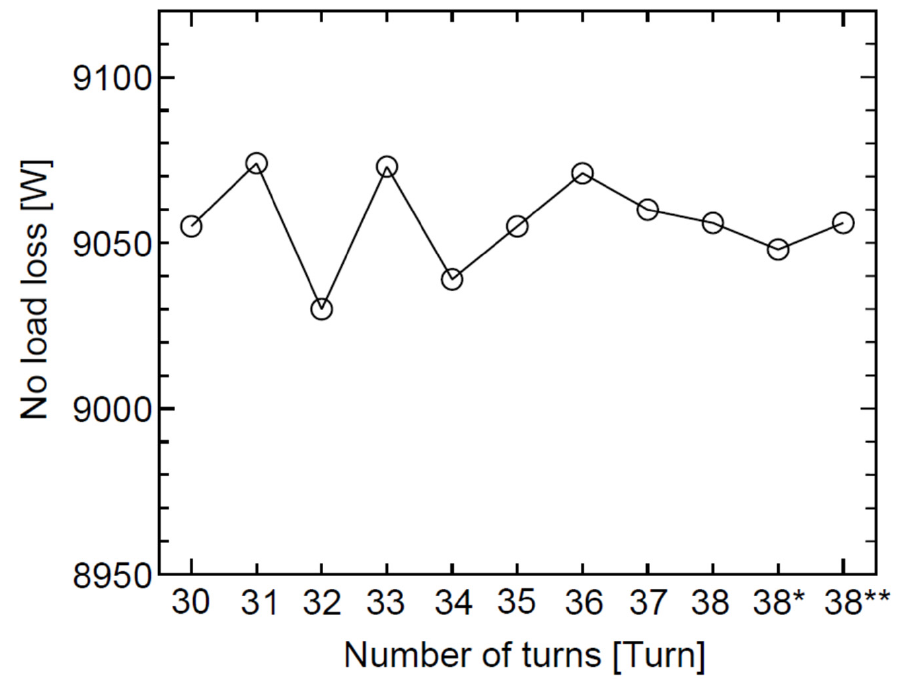
Figure 3. The no-load loss when the secondary winding changes.